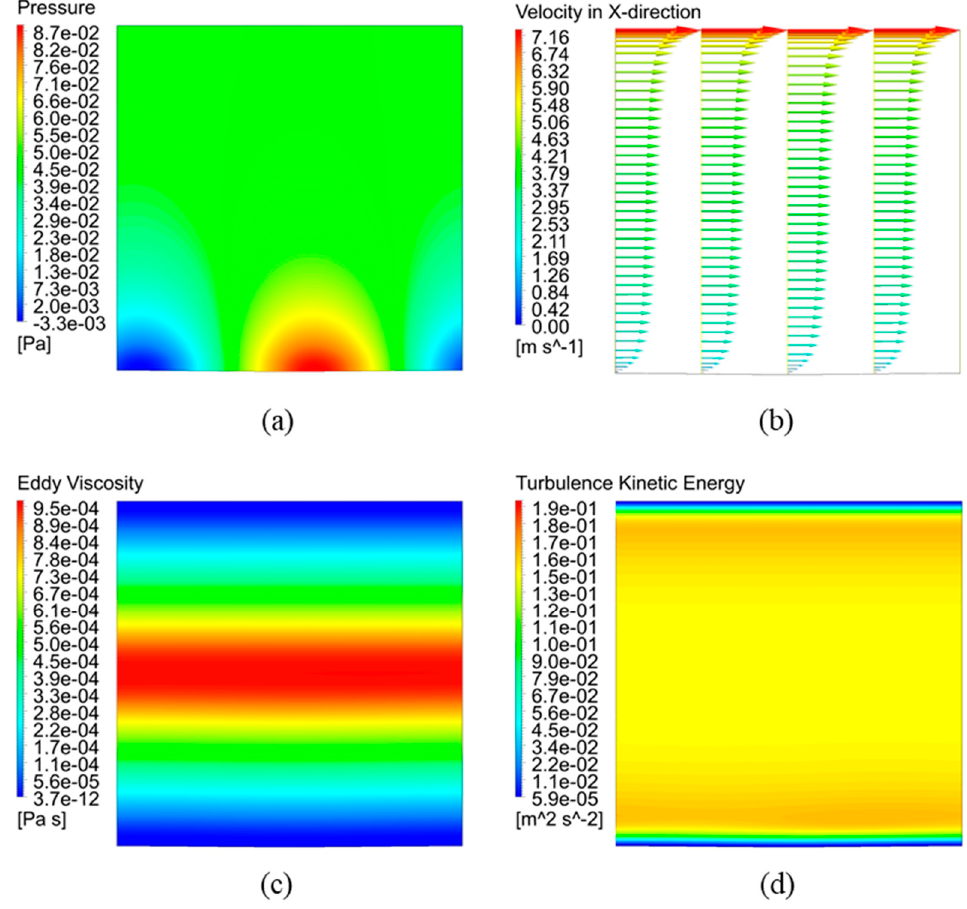
Figure 8. Contour plots for Base case. ( a ) Pressure, ( c ) Eddy viscosity; and ( d ) Turbulence Kinetic Energy; and ( b ) Vector plot of velocity in x-direction.